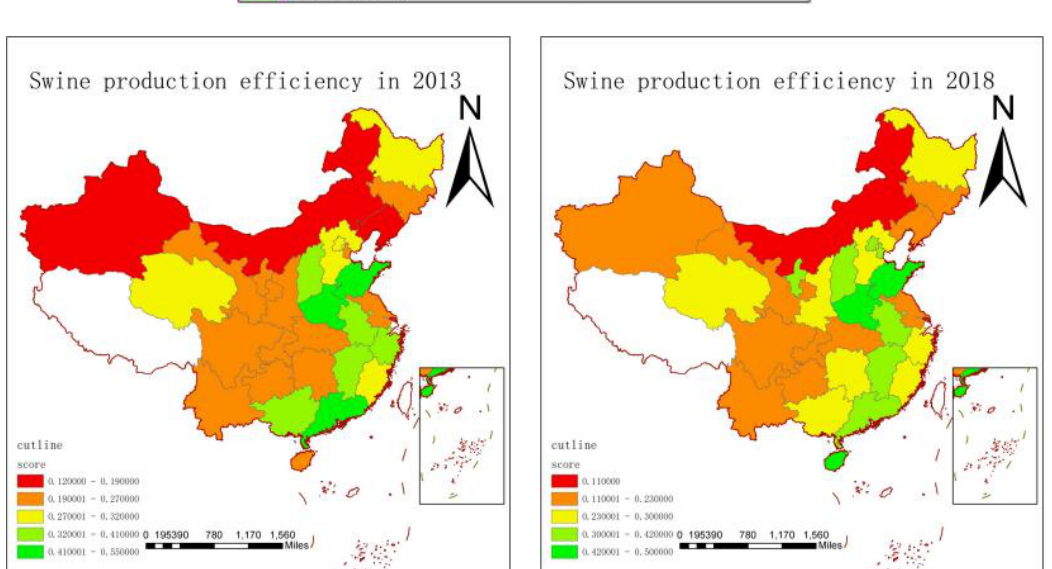
Figure 4. Swine production efficiency for 1998 – 2018.